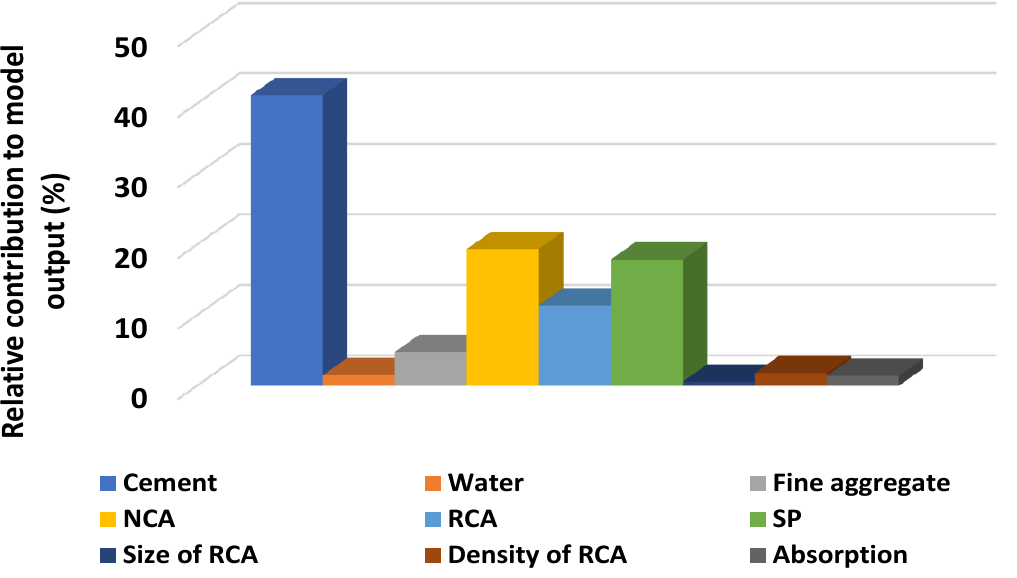
Figure 12. Contributing level of the input variables towards the prediction of output for STS.